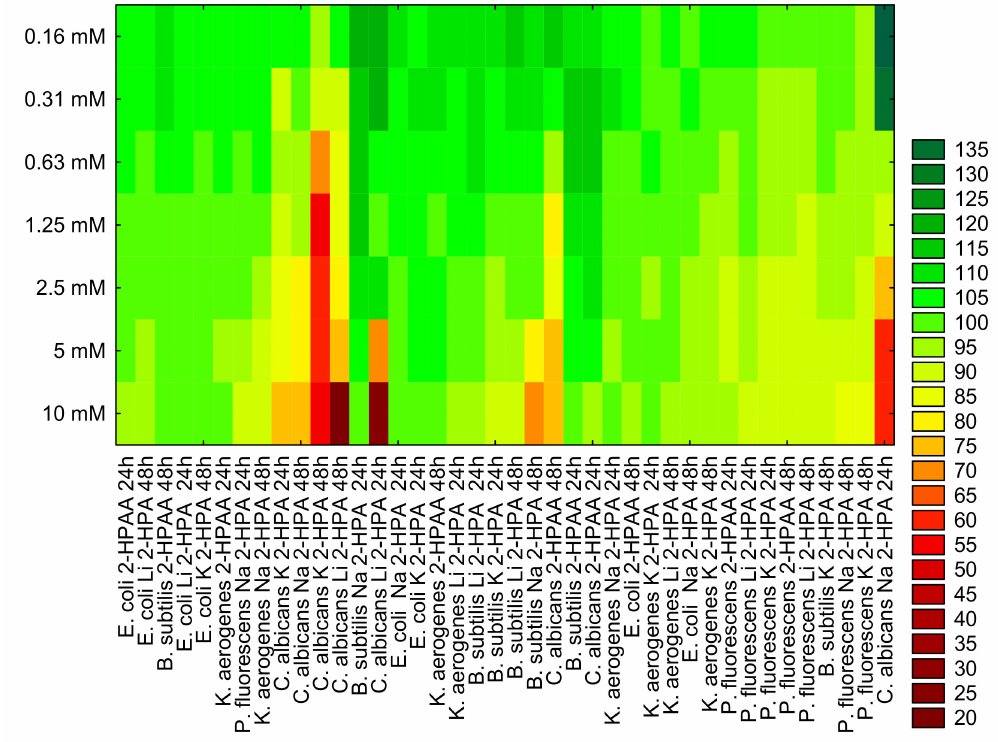
Figure 11. Cluster analysis grouping objects into similar groups based on relative bacteria ( E. coli , K. aerogenes , B. subtilis , and P. fluorescens ) and fungal ( C. albicans ) cells viability (%) after treatment of 2-HPAA and its alkali metal salts with Li (Li-2-HPA), Na (Na-2-HPA), and K (K-2-HPA) and their different concentration (0.16 mM, 0.31 mM, 0.63 mM, 1.25 mM, 2.5 mM, 5 mM, and 10 mM) after 24h and 48h of